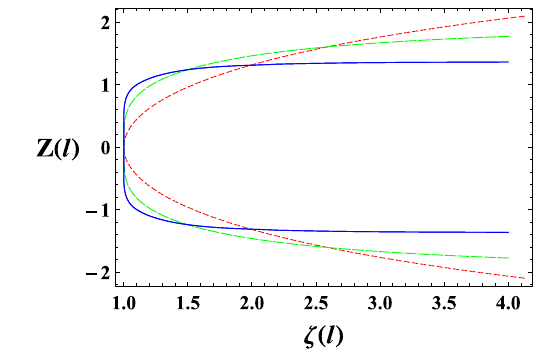
Fig. 1 Embedding of 4D-GEB wormhole geometry for different choice of “ m ” with b 0 = 1, where cases; m = 2 , 4 , 8 are represented by dotted-red, dashed-green and solid-blue curves, respectively